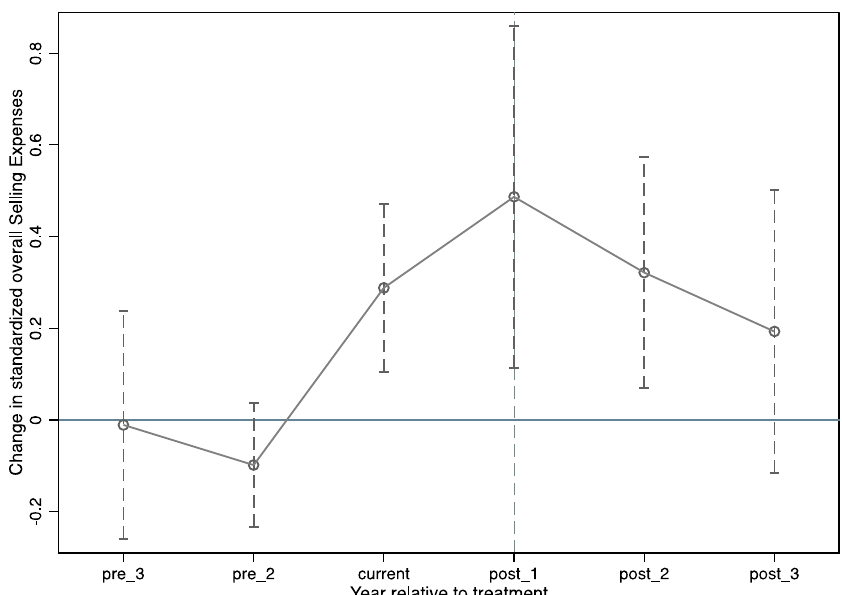
Figure 1. The Dynamic Impact of Two-Invoice System on Selling expenses. Table 5. Auxiliary Analysis.